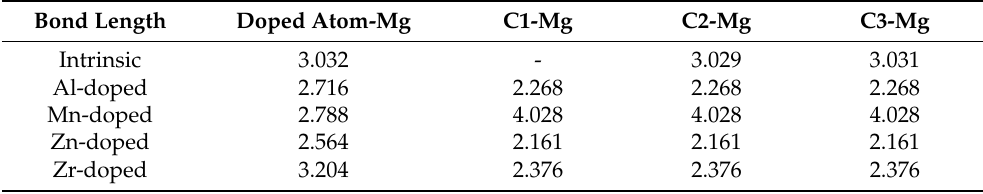
Figure 3. The interactions of magnesium with the intrinsic and doped graphene sheets. ( a ) Al-doped graphene sheet, ( b ) Mn-doped graphene sheet, ( c ) Zn-doped graphene sheet, ( d ) Zr-doped graphene sheet, ( e ) Intrinsic graphene sheet. Table 3. Bond lengths of the Al–Mg, Mn–Mg, Zn–Mg, Zr–Mg, and C–Mg in three directions following the Mg interactions (unit: